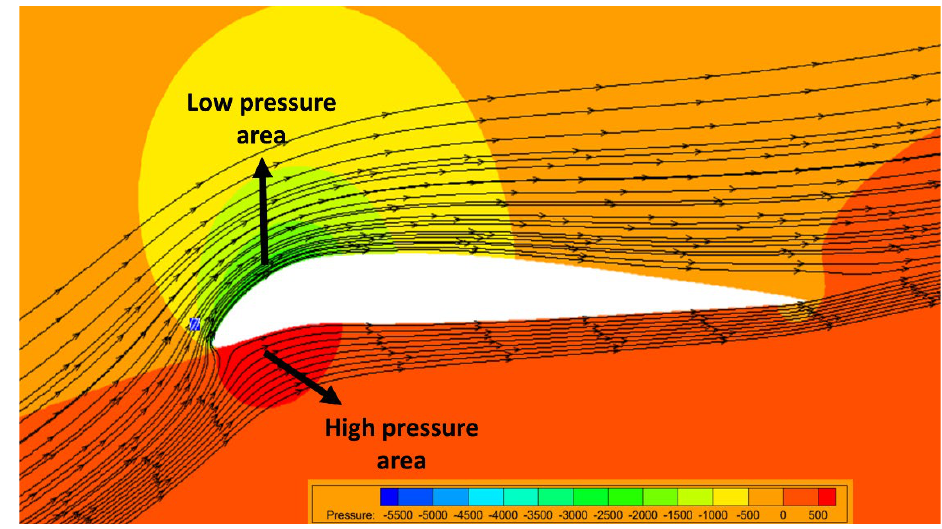
Figure 10. Pressure contour with streamlines of the morphing leading-edge